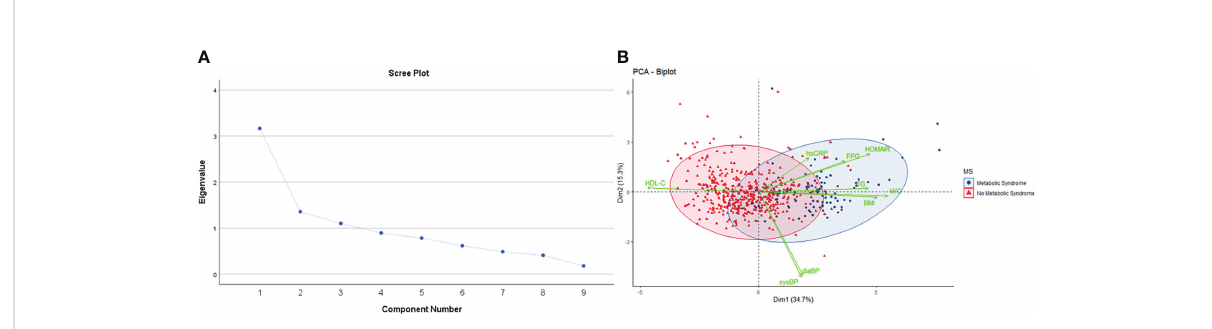
FIGURE 2 (A) Scree plot showing eigenvalue against all factors. Three factors have eigenvalues >1, and collectively explain 62.5% of the cumulative variance in the dataset. (B) PCA biplot shows individual observations as datapoints, colored according to presence or absence of metabolic syndrome. Points are plotted on a plane formed by the fi rst two principal components. The original variables are shown as green vectors from the origin. The orientation of the vector with respect to the principal component space represents its contribution to the PC.